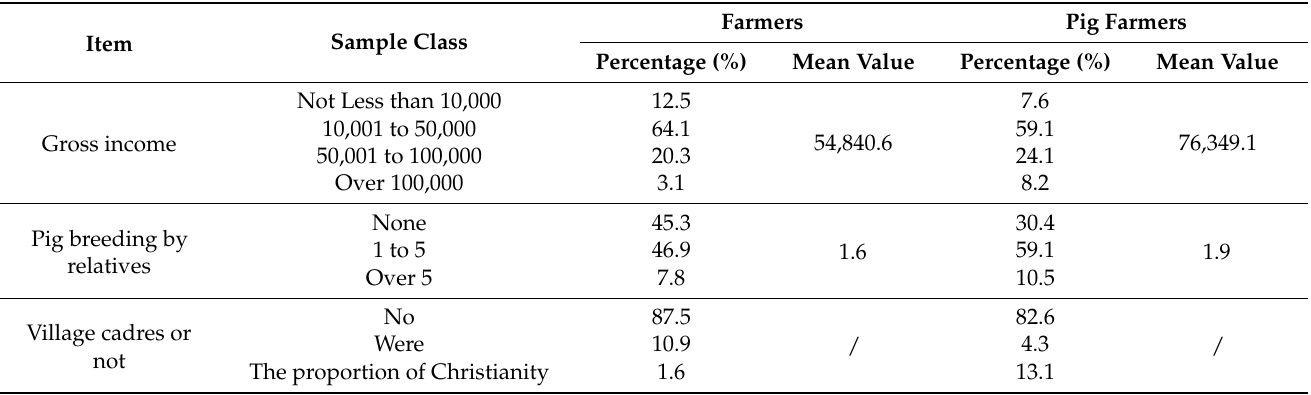
Table 2. The capability of each